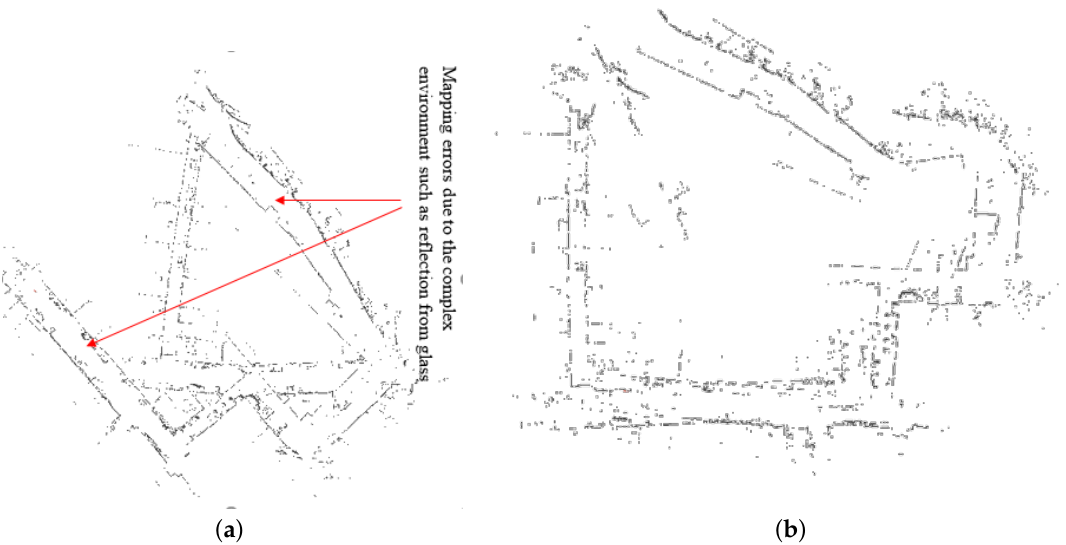
Figure 9. Comparison of Mapping Results with and without ITM near Building 37 on Monash Campus. ( a ) Mapping Result with original HectorSLAM. ( b ) Mapping Result with Proposed ITM Algorithm.